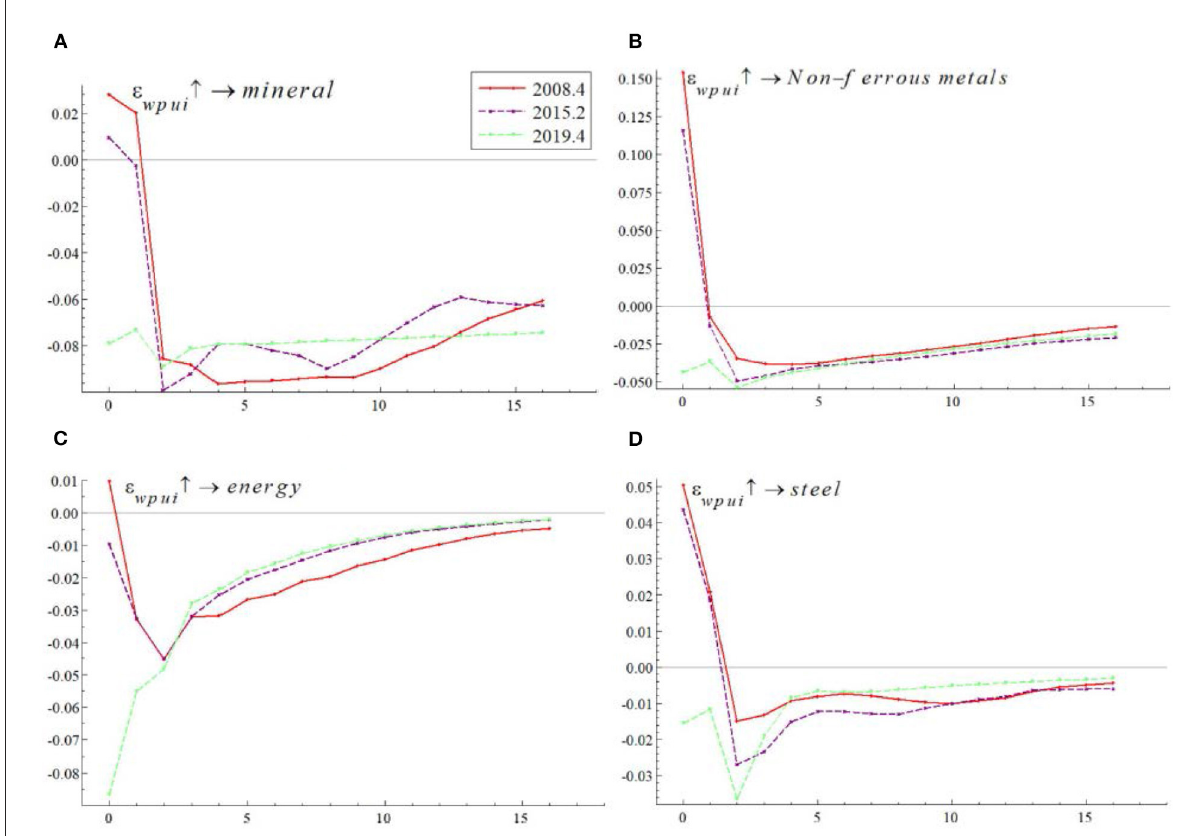
FIGURE6 Impact of WPU on the prices of different categories of commodities (i.e., (A) shows mineral, (B) shows non-ferrous metals, (C) shows energy, and (D) shows steel).